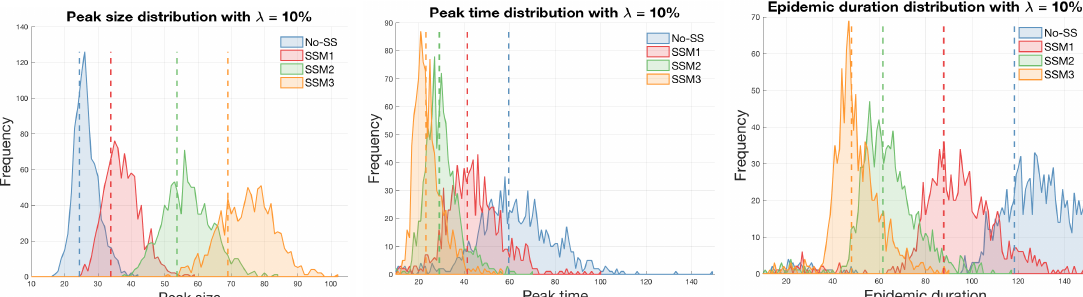
Figure 5. Distributions of three epidemic outcomes (peak size, peak time, and epidemic duration) are compared for each model using λ = 10% (the mean of each epidemic output is displayed as a dashed